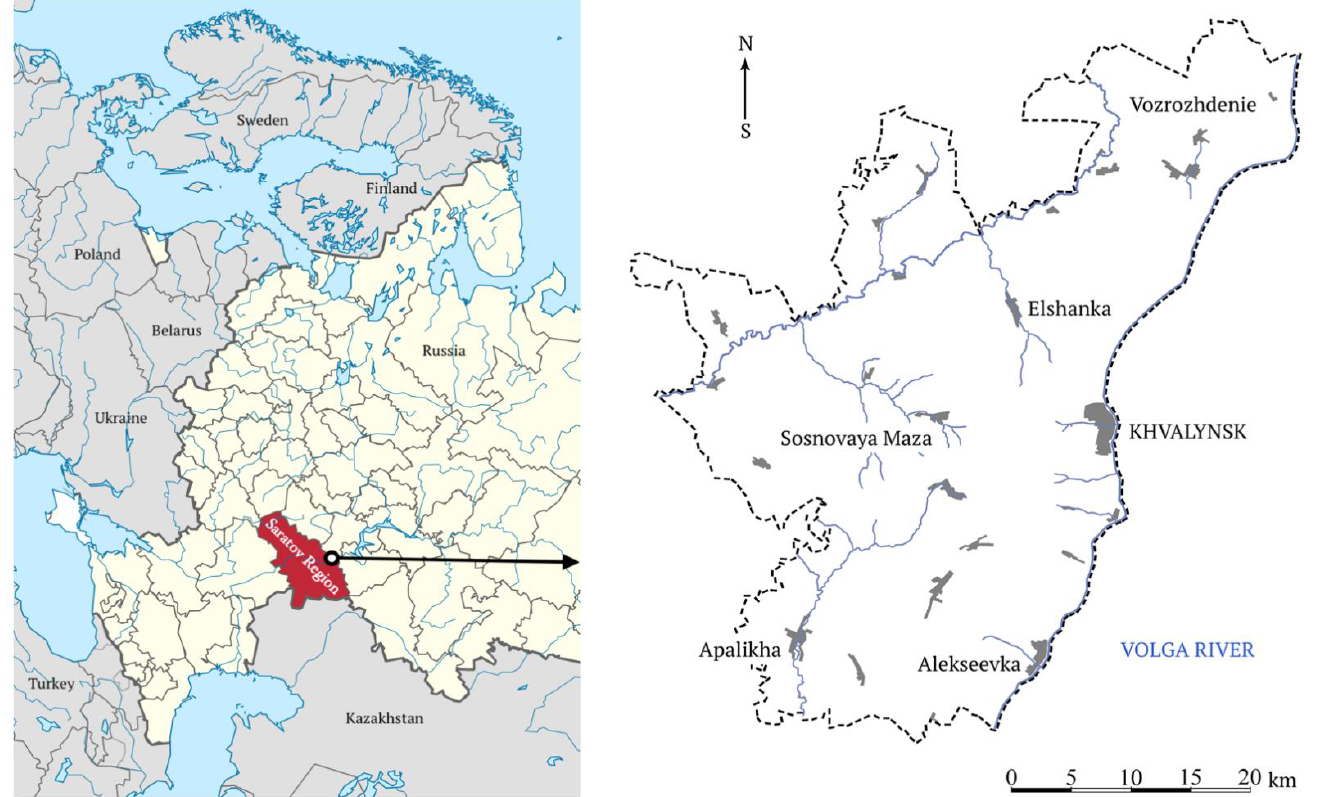
Figure 1. Map scheme of the Khvalynsky National Park. The basis for the map on the left was https://www.wikipedia.org/ (accessed on 13 September 2022), while the map on the right was drawn by L.V. Lavrentiev.